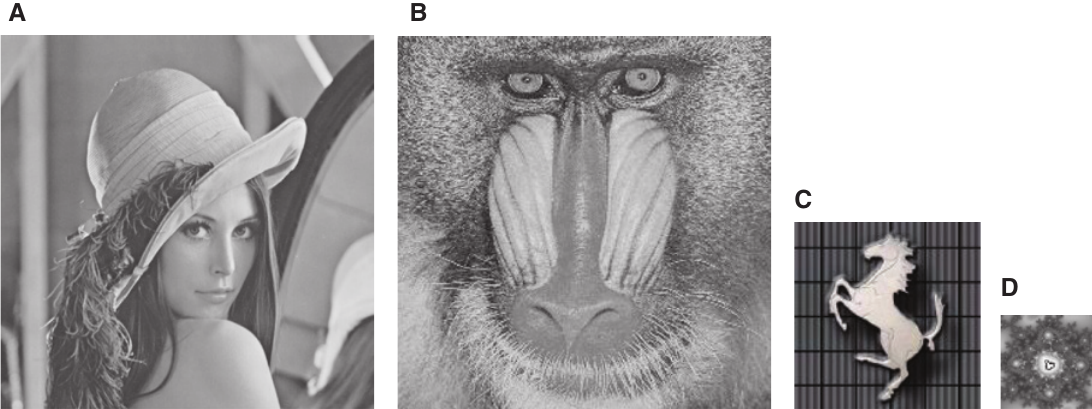
Figure 3: (A) Cover Image and Watermark Image of Size (B) 512 × 512, (C) 128 × 128, and (D) 64 ×